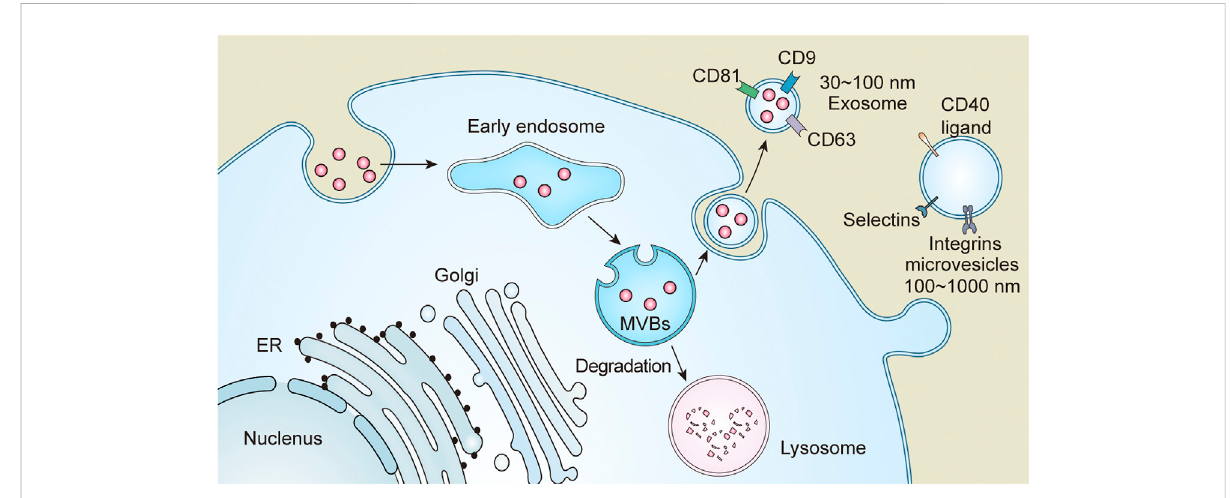
Extracellular vesicles (EVs) are divided into three categories based on size and function, which include exosomes, microvesicles and apoptotic bodies. Endosomes formed after endocytosis, and then become multivesicular bodies (MVBs) through a series of processes. MVBs are partly transportedtolysosomesfordegradationandpartlyfusedwiththeplasmamembraneorsecretedtotheoutsideofthecelltoformexosomesdueto its special sorting mechanism. Microvesicles are directly detached from the plasma